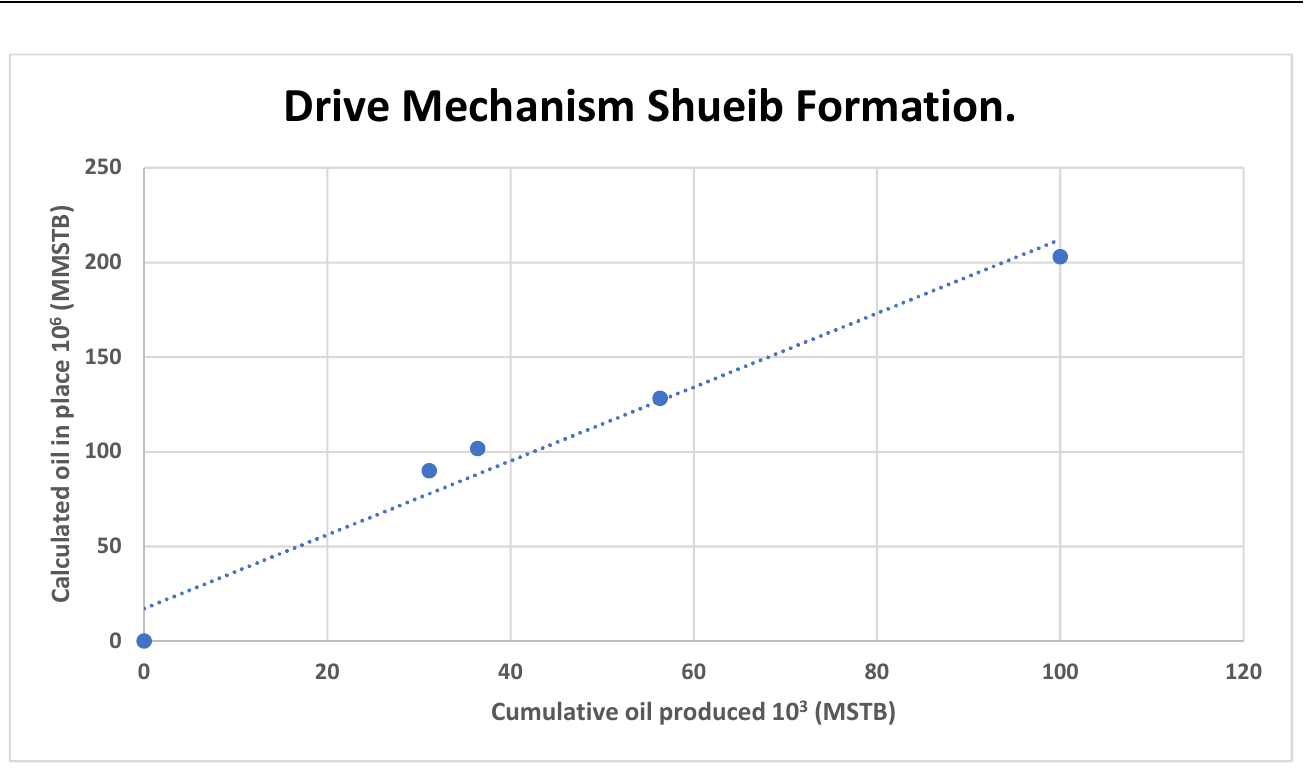
Figure 3. Calculated oil in place vs. cumulative oil production in the Hummar formation.